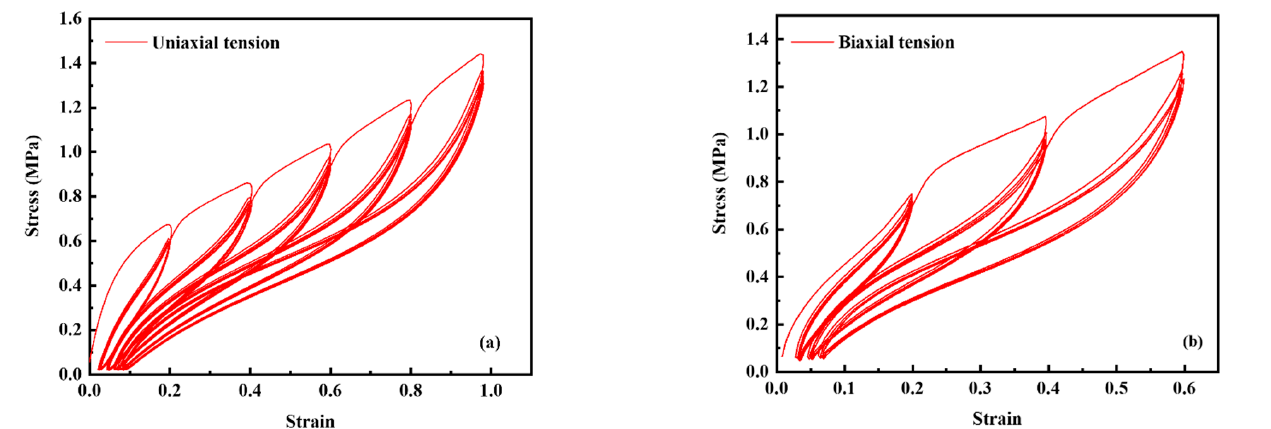
Figure 5. ( a ) The original cyclic stress–strain curves at five different peak strains in the deformation model of uniaxial tension, and ( b ) the original cyclic stress–strain curves at three different peak strains in the deformation model of biaxial tension.